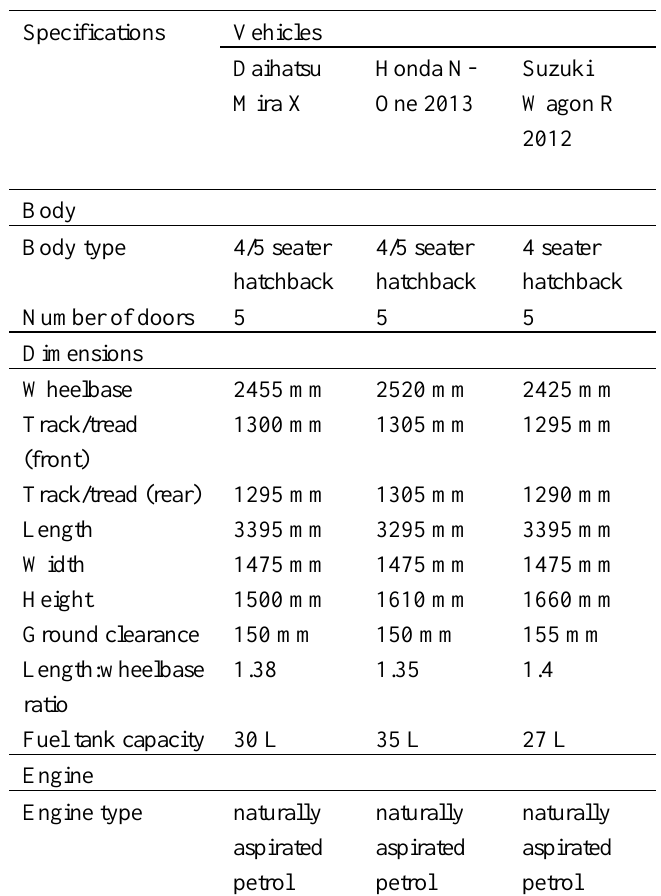
Detailed comparison of various specifications of Daihatsu Mira X, Honda N-One 2013, and Suzuki Wagon R